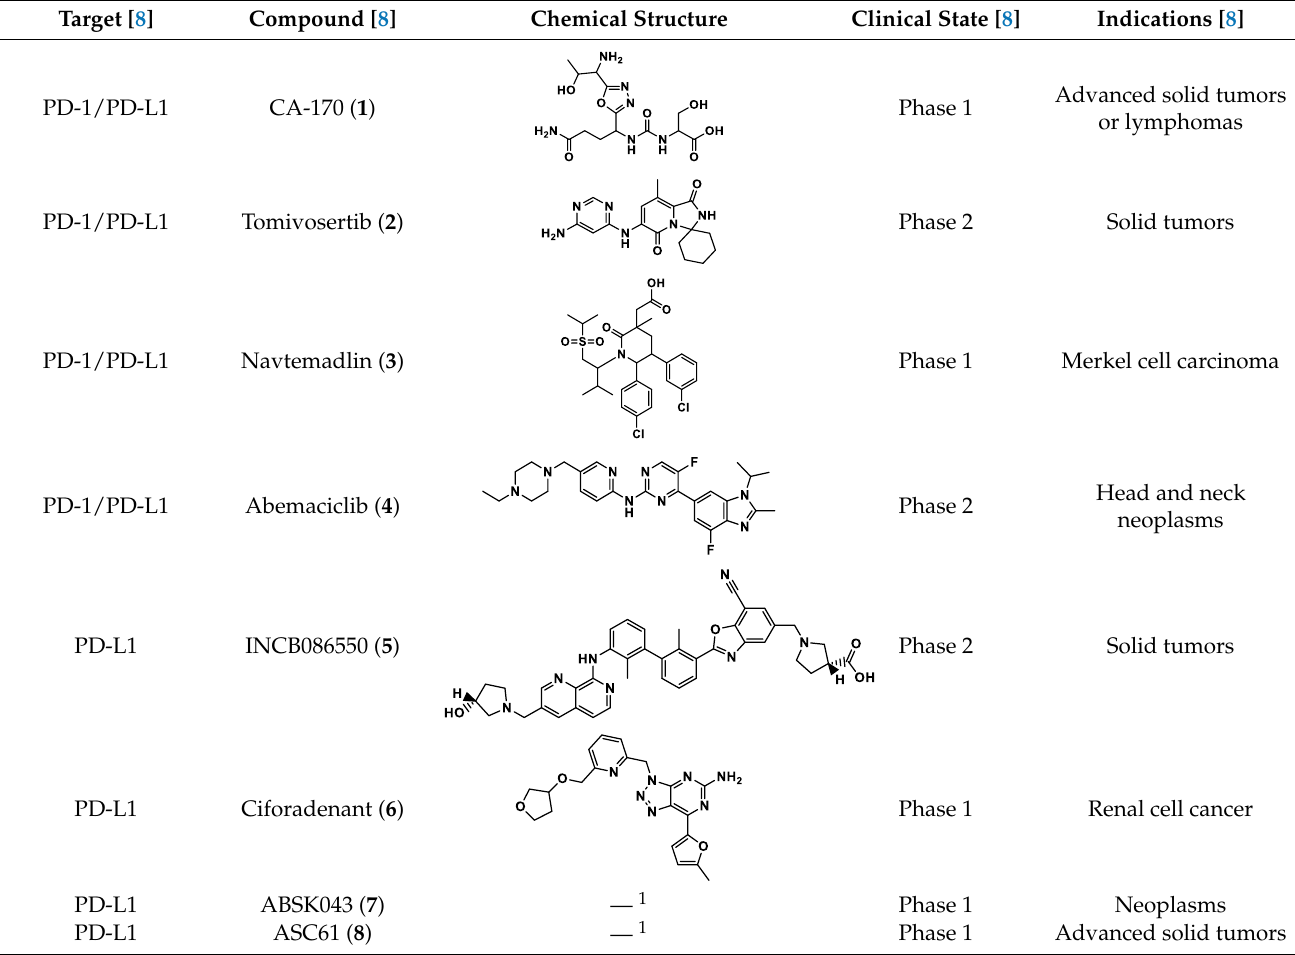
Table 1. Small molecule ( 1–8 ) ICIs targeting PD-1/PD-L1 in clinical